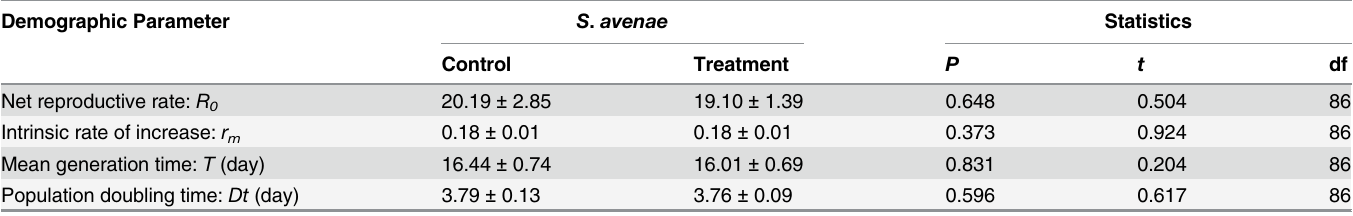
Table 5. Effect of LC 25 of pirimicarb on demographic parameters of S . avenae